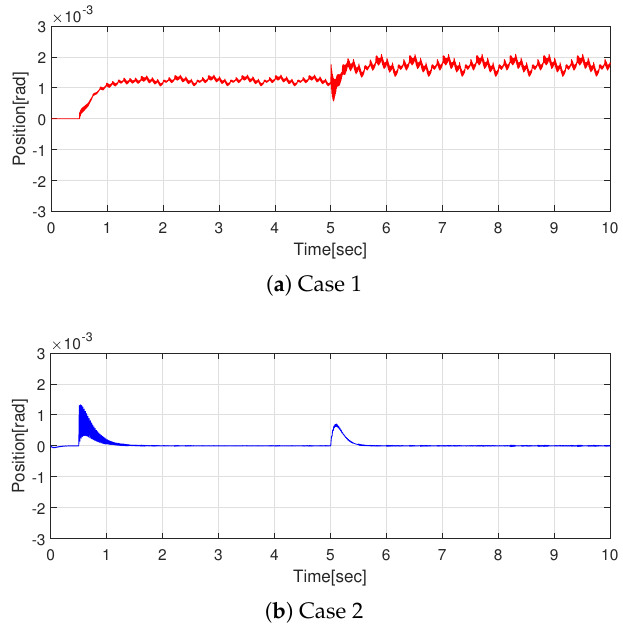
Figure 7. Position tracking